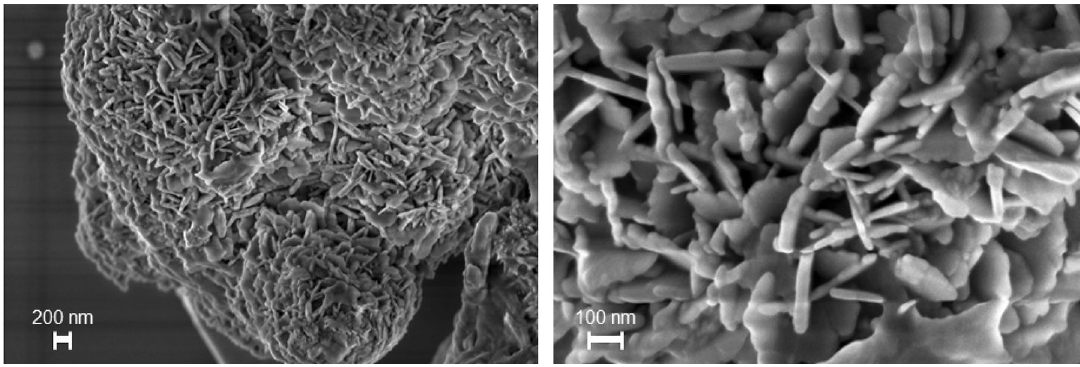
Figure 6. FESEM images of the Pd@slag 1 after one cycle of use in the overall